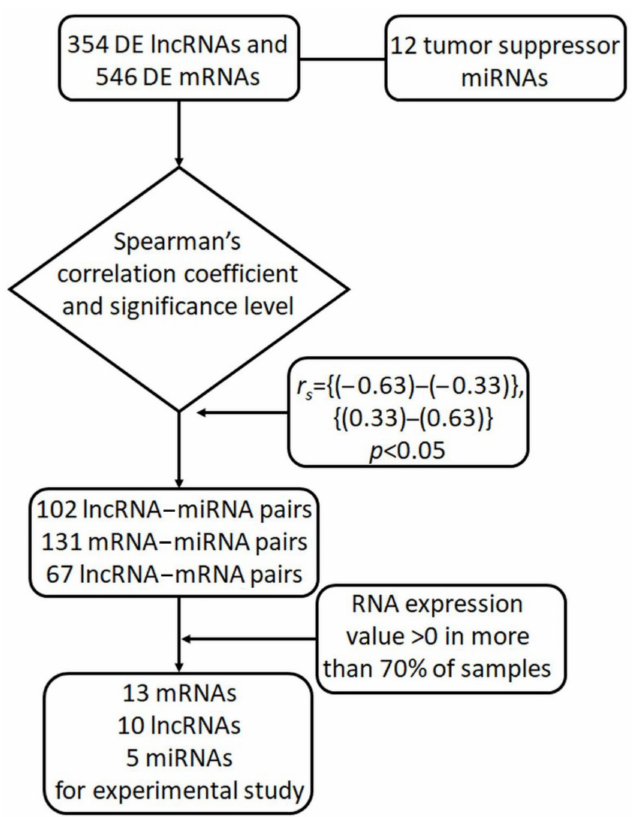
Figure 7. The workflow of bioinformatic analysis for identification of lncRNA–miRNA–mRNA